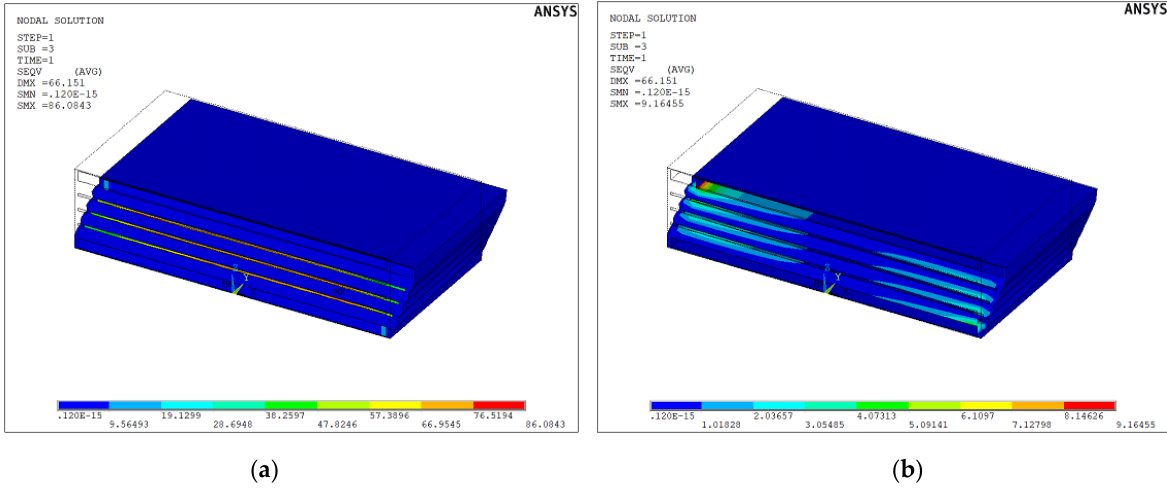
Figure 10. Stress distribution of elastomeric bearing with 9P M-R model as shear strain is 0.5 under the vertical pressure of 6 MPa: ( a ) for all domain; ( b ) for elastomer only.